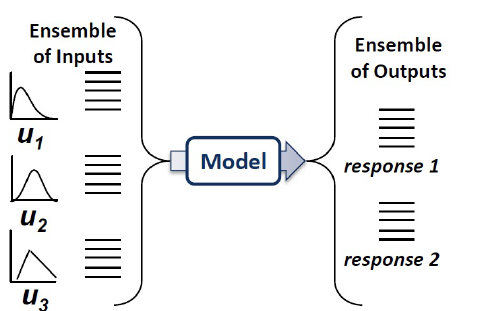
Figure 1. Realizations from specified input distribu- tions being run in a model